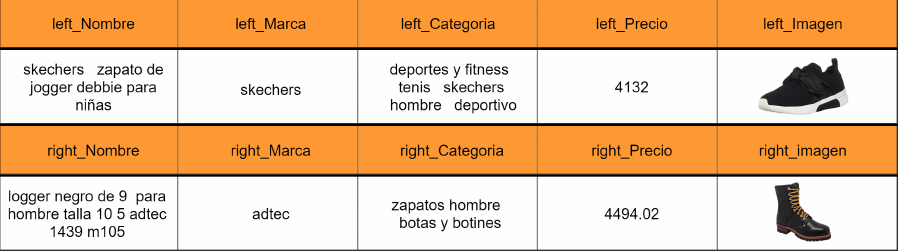
Figure 4. Database